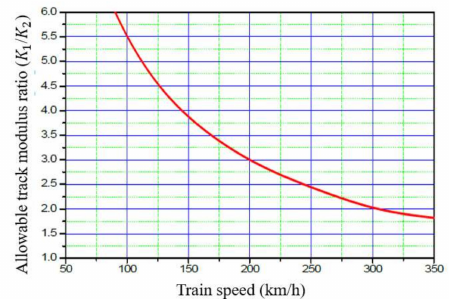
Figure 2. Allowable track modulus change depending on the train speed